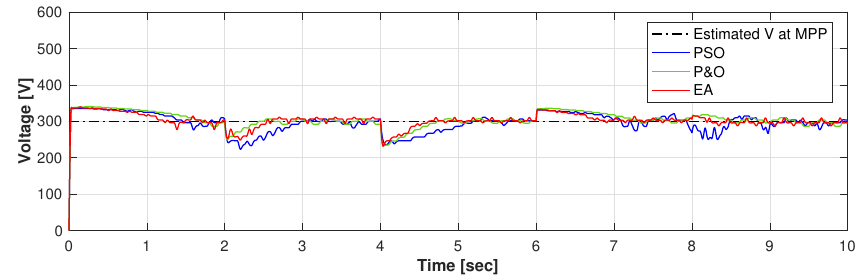
Figure 20. Voltage from the PV source ( V pv ) through time from high power